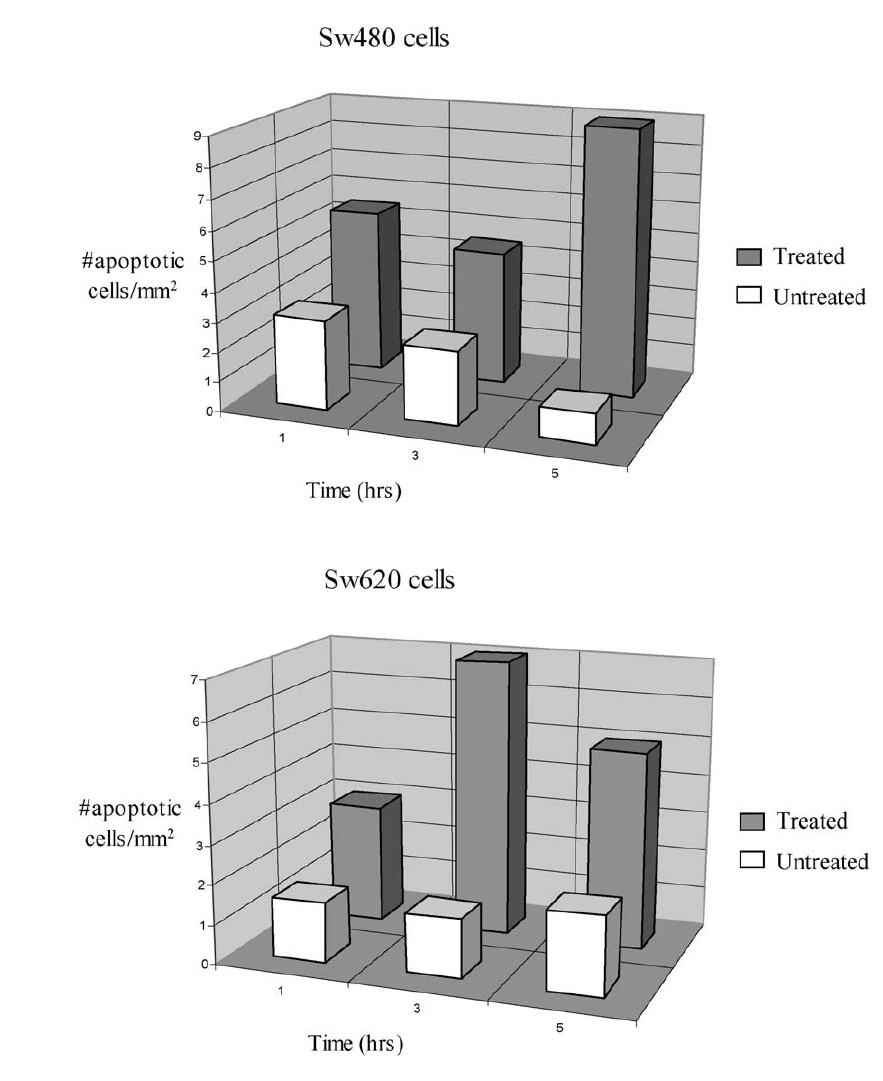
Fig. 2. Graphs showing an increase in the number of apoptotic cells per mm 2 in valinomycin treated samples compared with normal cells. These were assessed using morphology based on HE-stained cells. Counts were performed as described. After 5 hours detachment of cells from the coverslips made assessment